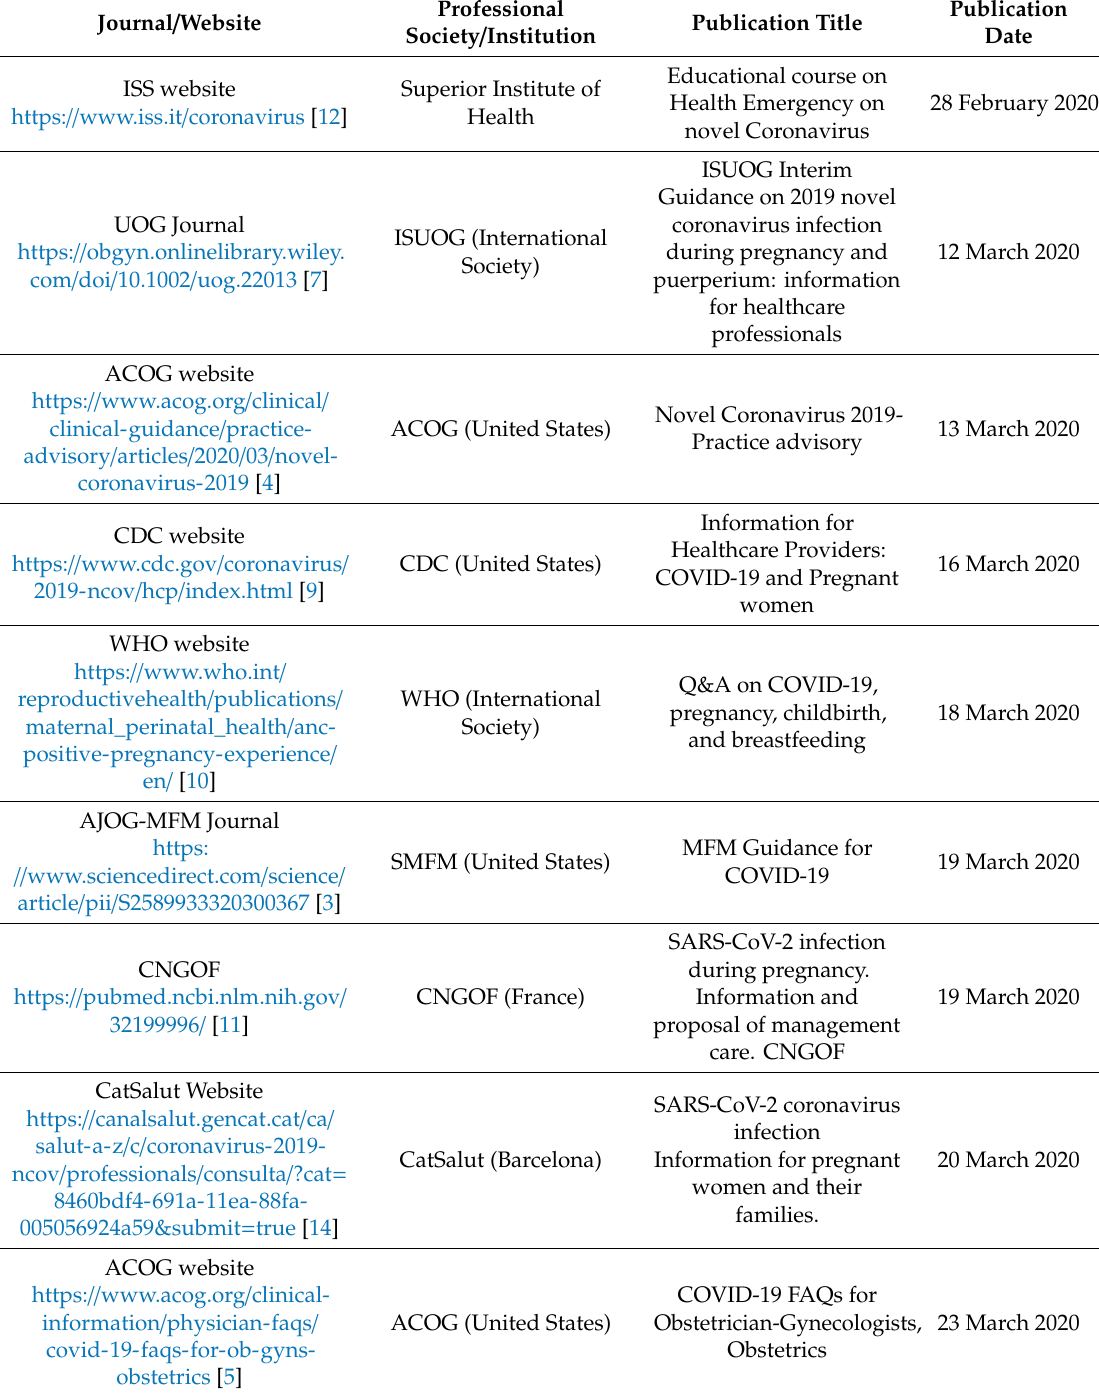
Table 1. Sources of